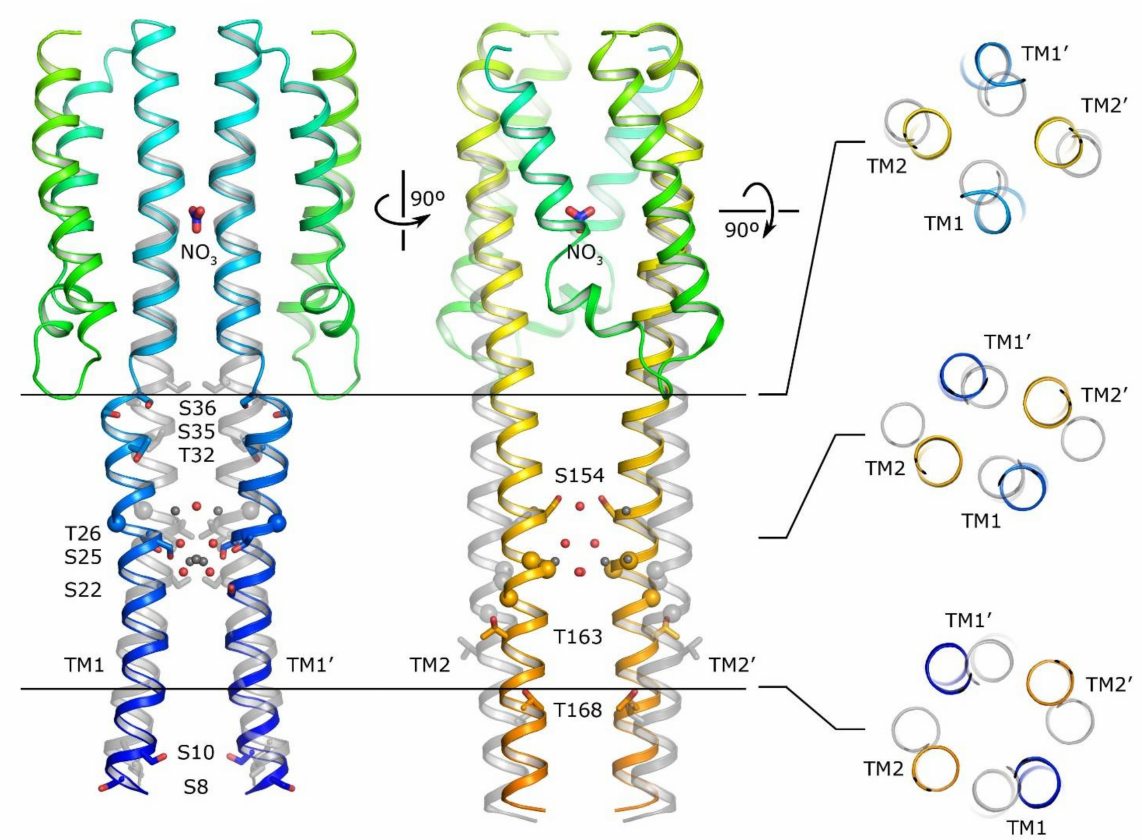
Figure 7. Signaling-associated conformational changes in the NarQ sensor and TM domains. Superposition of the symmetric ligand-free structure (gray) and symmetric ligand-bound structure (colored) is shown. The binding of nitrate causes downward displacement of TM1 and upward displacement of TM2, alongside with rearrangements in the membrane plane. Left : Changes in the conformation of helix TM1. Center: Changes in the conformation of helix TM2. Right : Changes in the arrangement of the TM helices. Serine and threonine side chains are shown explicitly, glycine C α atom positions are marked with the spheres. Positions of water molecules in the TM region are shown with gray (apo) or red (holo) spheres. The structures are aligned by the sensor domains. Adapted from